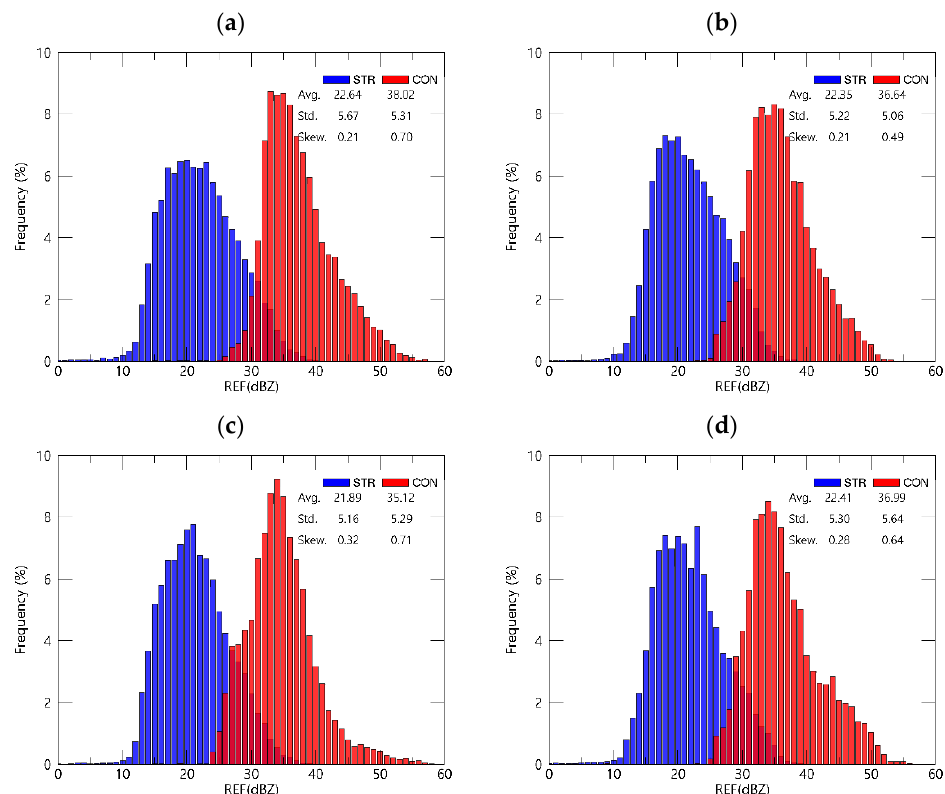
Figure 12. The occurrence frequency of reflectivity with rain types at ( a ) BOS, ( b ) BUS, ( c ) CPO, and ( d ) JIN site. The blue represents stratiform rain and the red represents convective rain. The legend shows the average (Avg.), standard deviation (Std.), and skewness (Skew) of reflectivity for both rain types.